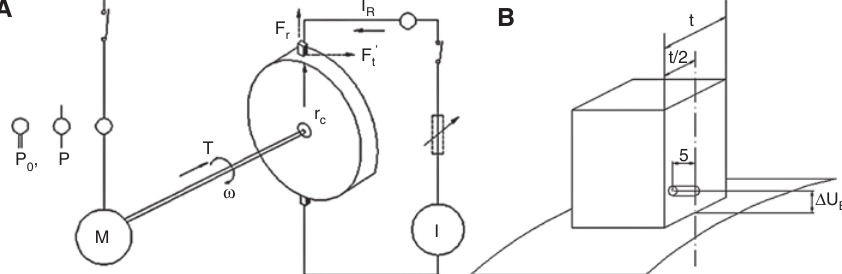
-graphite-multi-wall WS 2